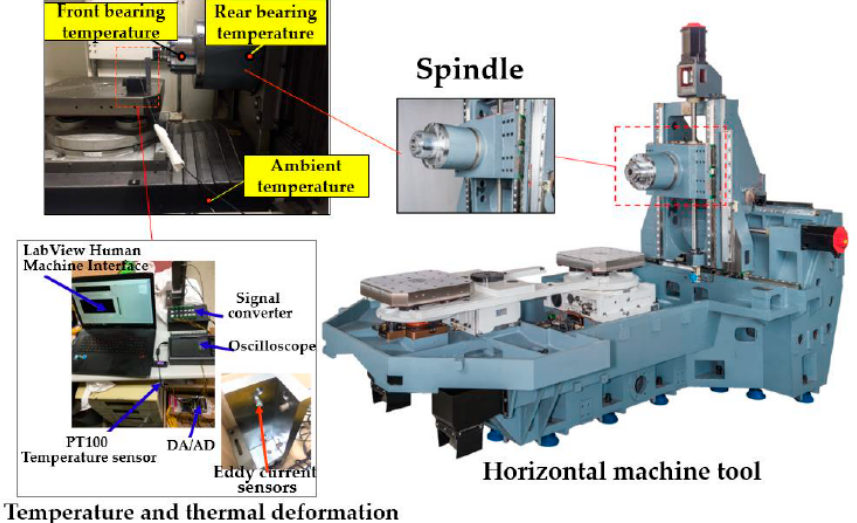
Figure 4. Spindle thermal deformation measurement.